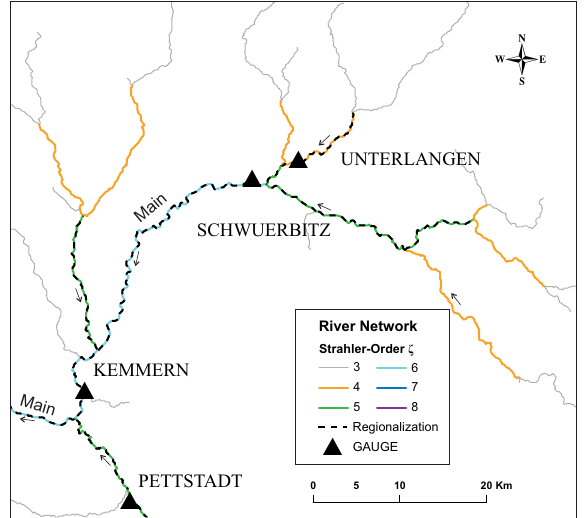
Fig. 3. Scheme applied to regionalise the discharge peaks at each gauge to the river network of the upper or intermittent catchment, respectively. Those parts of the network which are used for the regionalisation are highlighted by the dashed lines. The entire river network used as a result of the regionalisation is shown in Fig.